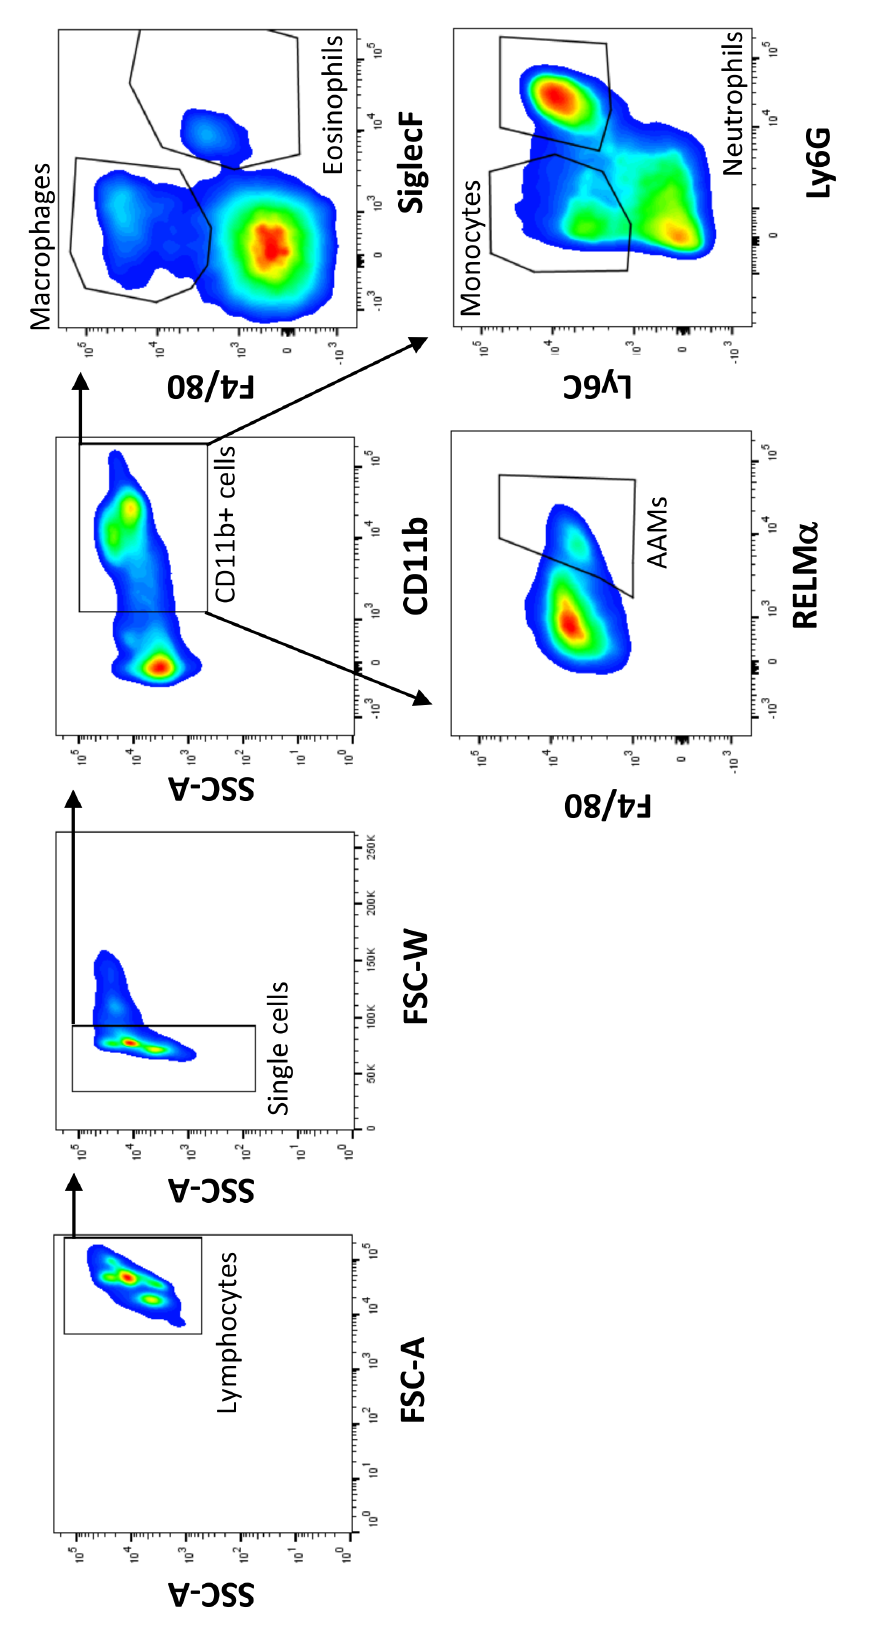
Figure 1: Gating strategy used for flow